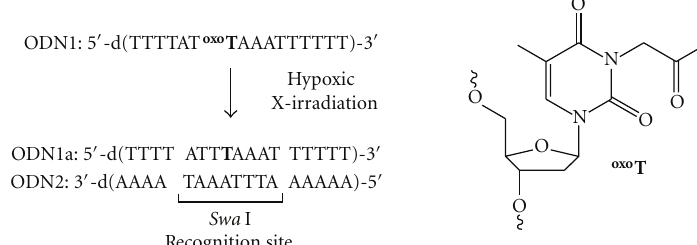
Figure 3: Radiolytic activation of 2-oxoalkyl caged oligodeoxynuleotides. Emergence of ordinary duplex formation by hypoxic X-irradiation.